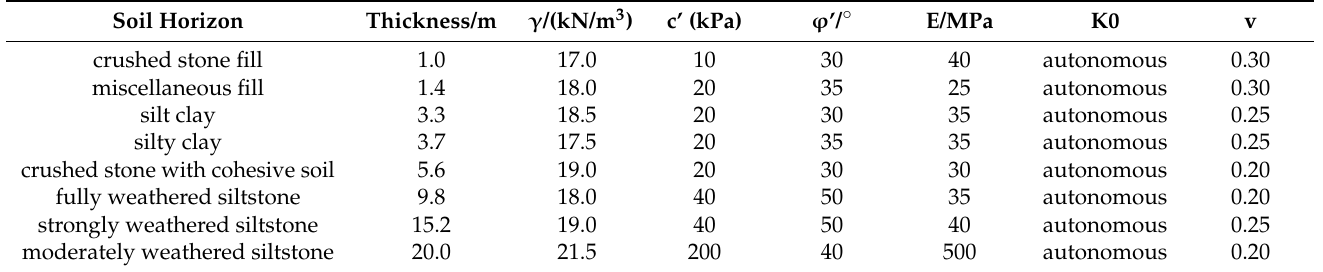
Table 2. Soil layer distribution and soil physical and mechanical